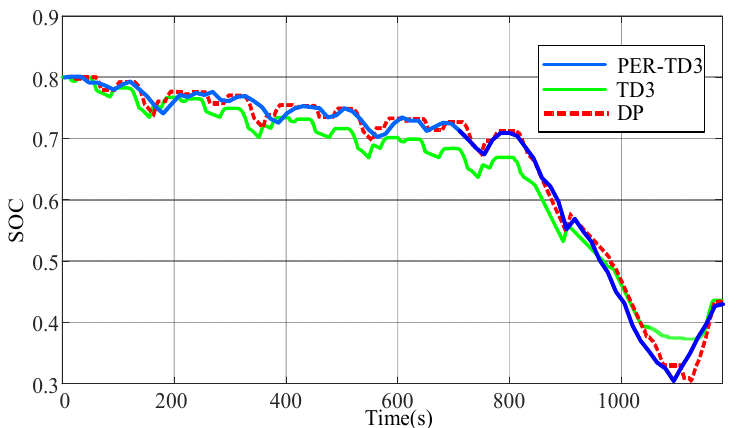
Figure 11. SOC curve of TD3 and DP. Figure 11 . SOC curve of TD3 and DP. Figure 11 . SOC curve of TD3 and DP.